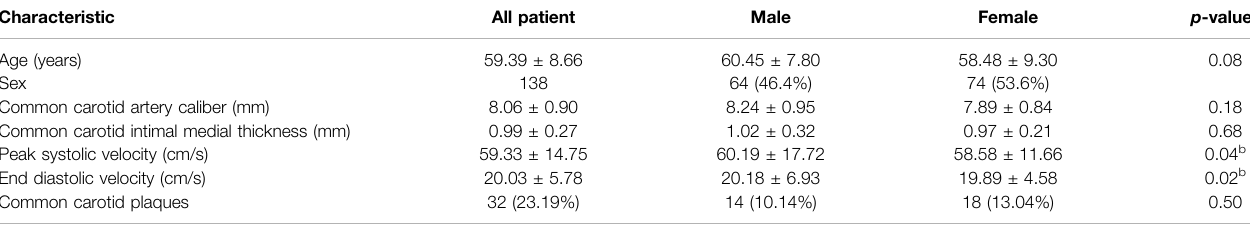
TABLE 1 | Clinical characteristics and carotid ultrasonographical variables of participants, strati fi ed by sex [mean (±Std) or n (%)]. Characteristic